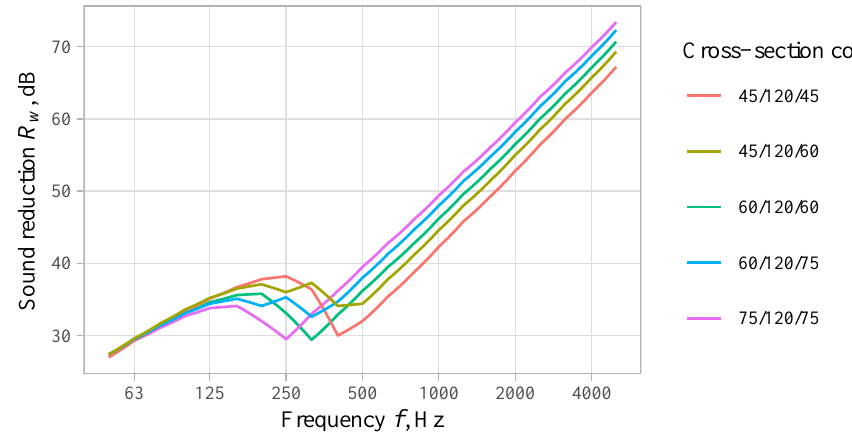
Figure 11. Sound reduction influenced by different thicknesses of SFRC